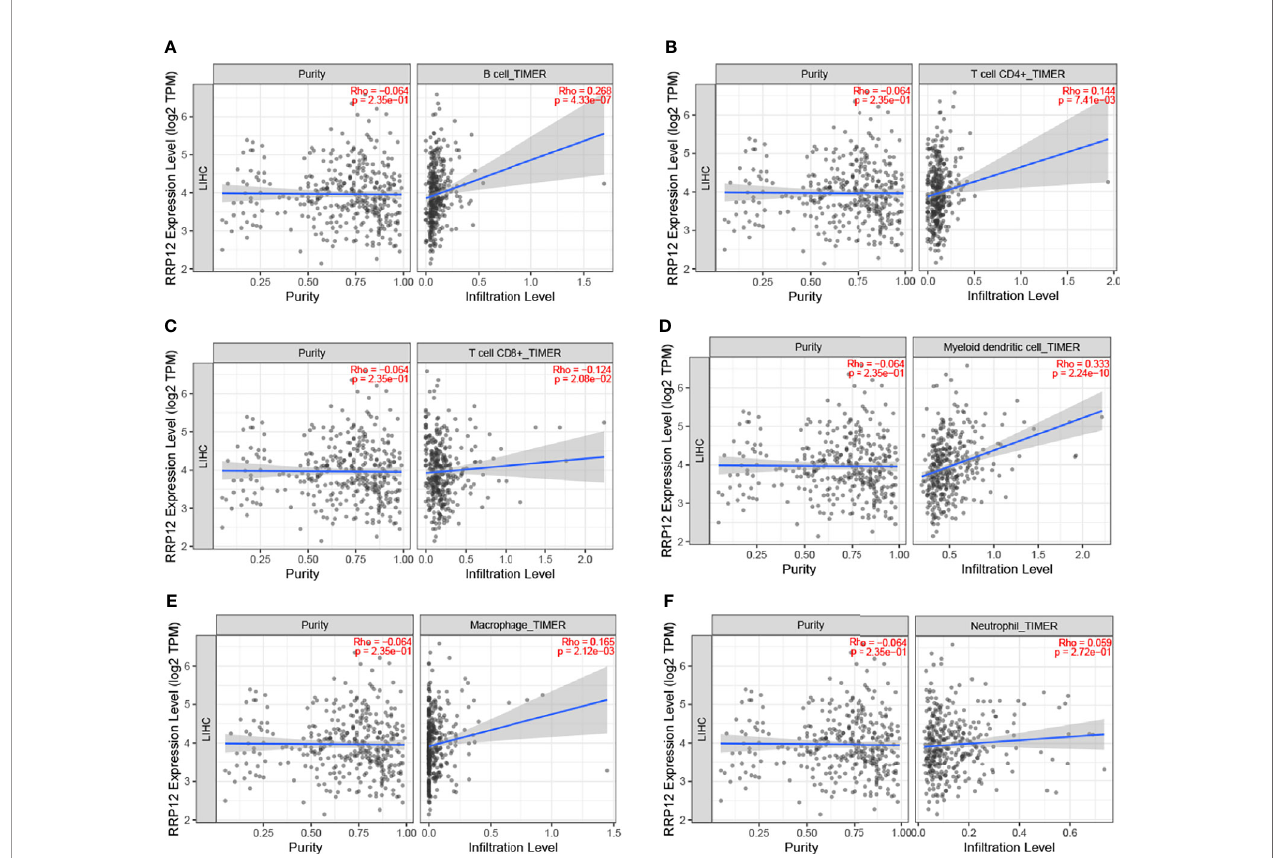
FIGURE 6 | The relationship of immune cell in fi ltration with RRP12 expression level in HCC. The correlation of RRP12 expression level with B cell (A) , CD8+ T cell (B) , CD4+ T cell (C) , dendritic cell (D) , macrophage (E) , and neutrophi (F) in fi ltration level in